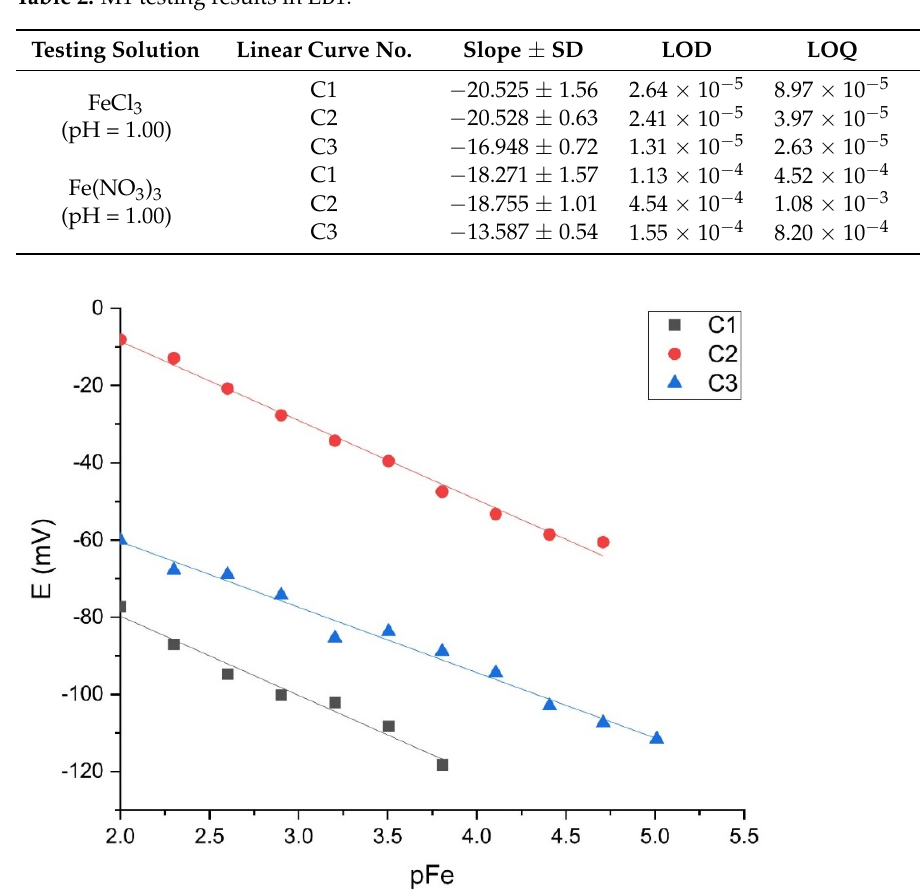
Figure 8. Results were obtained for Fe3+ cation determination in the ferric chloride solution using the M1 sensor.